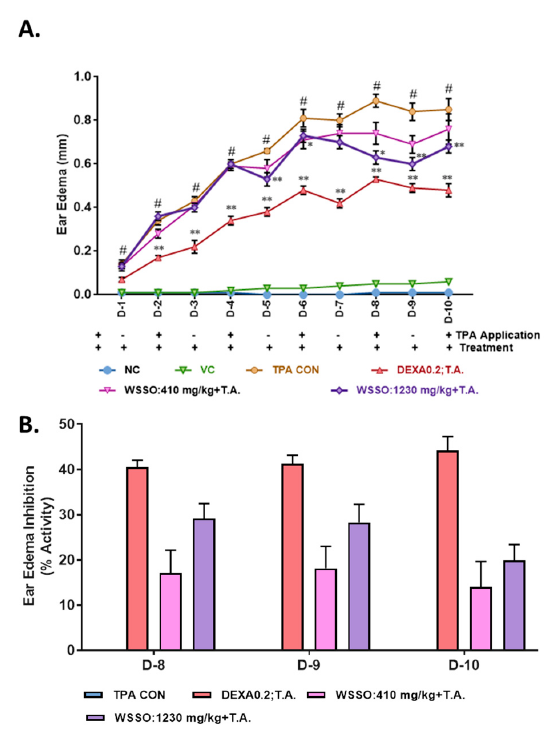
Figure 4. WSSO reduced ear edema in a TPA-induced psoriasis-like mouse model: Application of TPA resulted in increased ear edema, ( A ) reduction in psoriasis-induced edema was observed in WSSO treatment of 410 and 1230 mg/kg, supplemented with topical application (T.A.) of 20 µL of WSSO. At 1230 mg/kg dose, significant reduction in ear edema was observed. Dexamethasone (DEXA) was taken as positive control and acetone was used as vehicle control. ( B ) Percent ear edema inhibition was calculated by deriving data from panel ( A ), WSSO at 1230 mg/kg displayed increased inhibition of edema (20%–30%) compared to 410 mg/kg (12%–25%), DEXA displayed ~40% inhibition in the ear edema. Highest percentage ear edema inhibition (25%–30%) was observed on day 9, with dose-dependent inhibition on the days 8, 9, and 10. All values are presented as mean ± SEM, n = 6 animals in each group, p -values, # p < 0.001 (NC vs. TPA), * p < 0.05, ** p < 0.001 (WSSO treated vs. TPA CON).